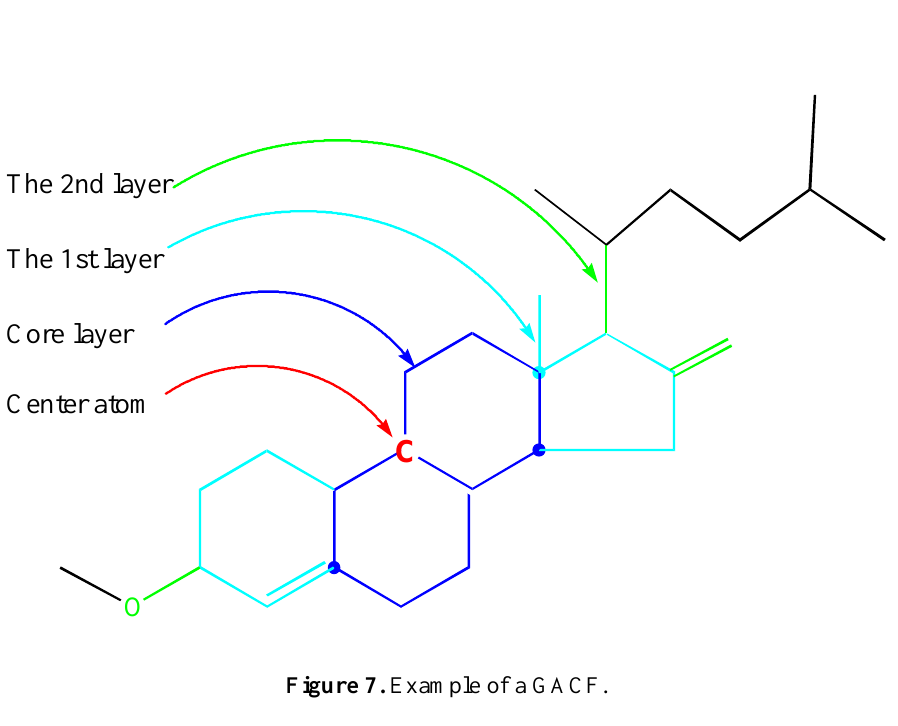
Figure 7. Example of a